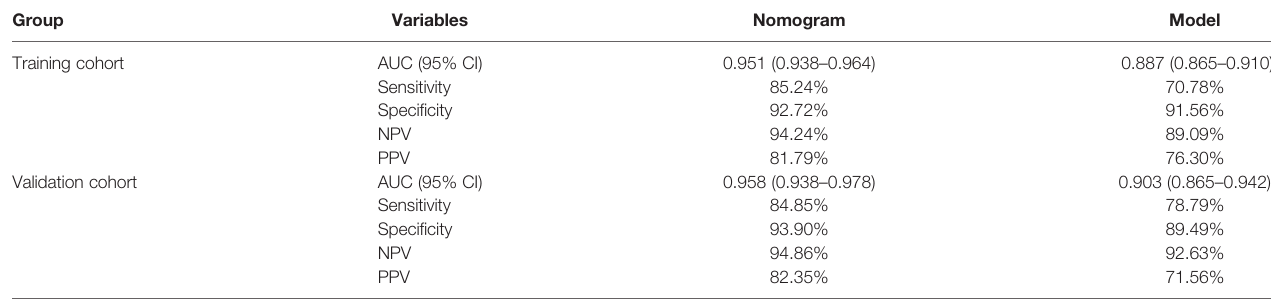
TABLE 4 | Diagnostic ef fi cacies of the nomogram and compared model for distinguishing between ICC and HCC.